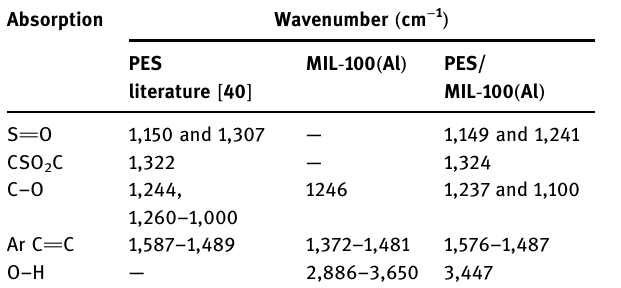
Table 2: Comparison of the absorption peaks of the PES from the research results with that of the PES from the literature Absorption